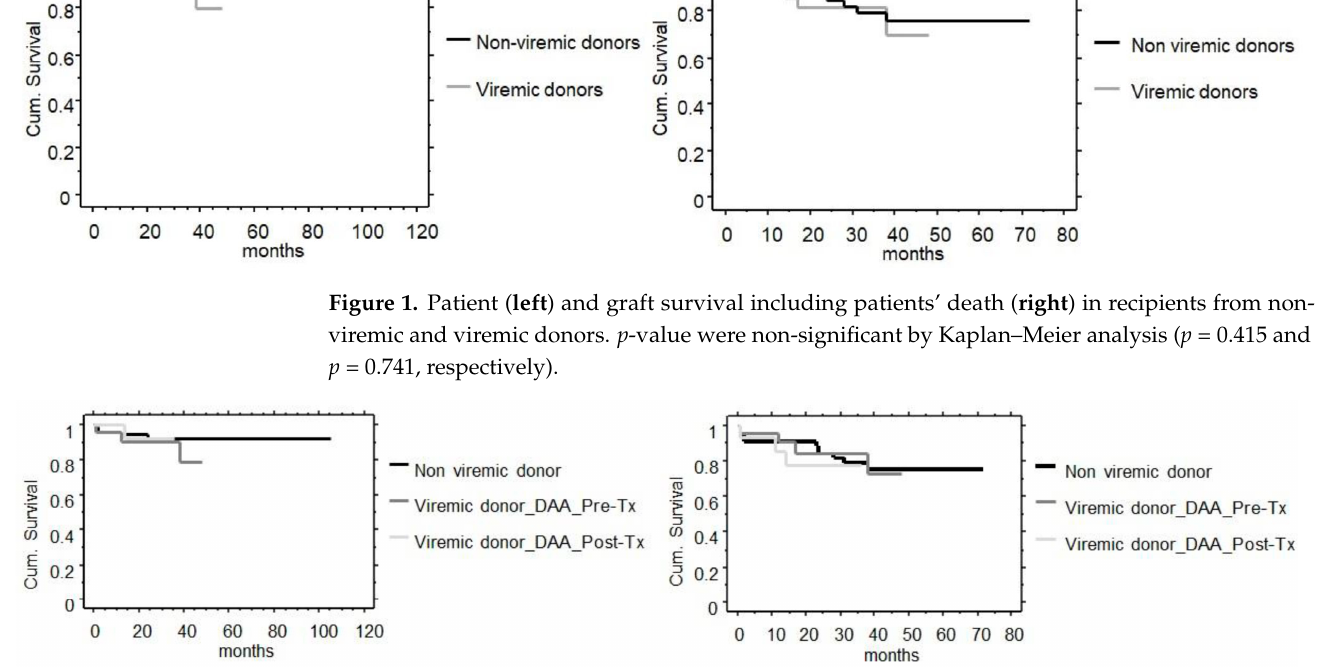
Figure 2. Patient ( left ) and graft survival including patients’ death ( right ) in recipients from non- viremic and viremic donors either starting DAA treatment pre-transplant or post-transplant. p -values were non-significant by Kaplan – Meier analysis ( p = 0.614 and p = 0.768, respectively).